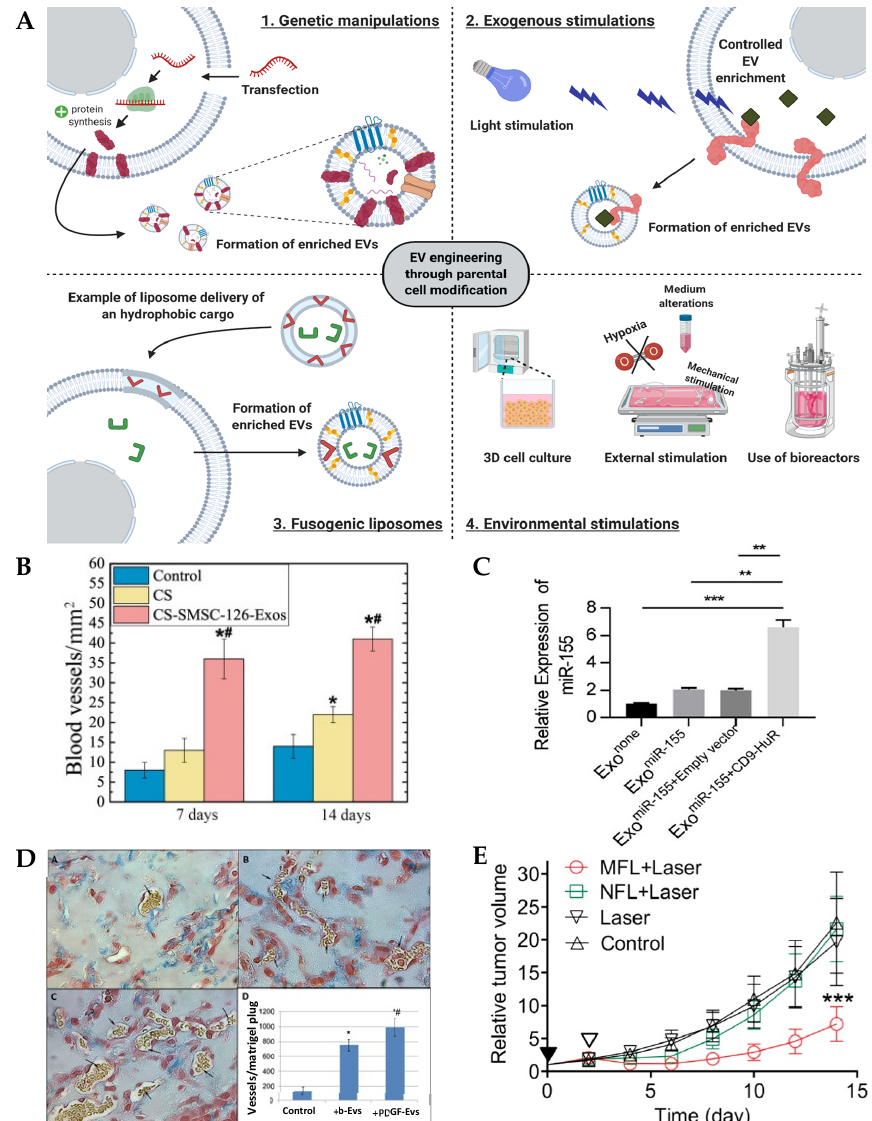
Figure 2. Engineering EVs by parental cell modification. ( A ) Schematic representation of methods to engineer EVs through parental cell genetic modification, stimulation with exogenous molecules, the use of fusogenic liposomes or environmental stimulation. ( B ) EVs derived from miR-126 overexpressing mesenchymal stem cells (MSCs) significantly increased vessel formation in a mice model. Reproduced from [31], with permission from John Wiley and Sons, 2016. *, p < 0.05 compared with control; #, p < 0.05 compared with CS. ( C ) CD9-human antigen R (HuR) enriched miR-155 into EVs with the miRNA e ffi ciently delivered to the recipient cells, demonstrated by significantly increased miR-155 expression in the human monocytic cell line THP1. Reproduced from [34], with permission from American Chemical Society, 2019. **, p < 0.01; ***, p < 0.001. ( D ) Platelet-derived growth factor (PDGF)-stimulated EVs ( + PDGF-EVs) exhibited substantially increased angiogenesis when compared to untreated EVs ( + b-EVs). Black arrows indicate vessel formation. Adapted from [46], under the creative commons licence, 2014. *, p < 0.05 compared with control; #, p < 0.05 compared to b-Evs. ( E ) Reduced tumour volume observed in liposome-fused EVs (MFL + laser) when compared to liposomes treatment and laser irradiation alone. Reproduced from [51], with permission from American Chemical Society, 2015. ***, p <